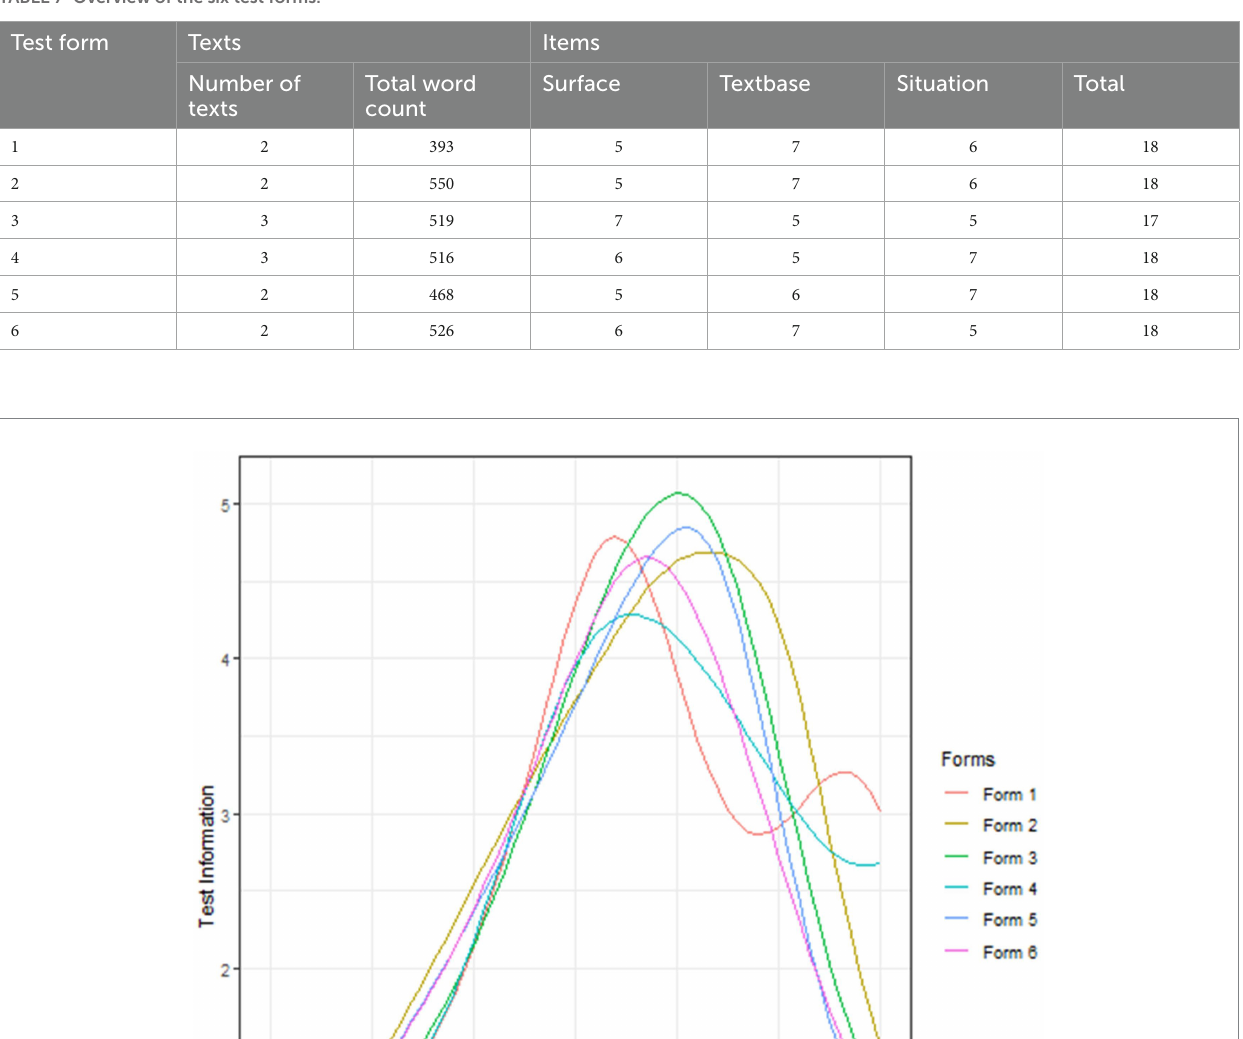
TABLE 7 Overview of the six test forms.